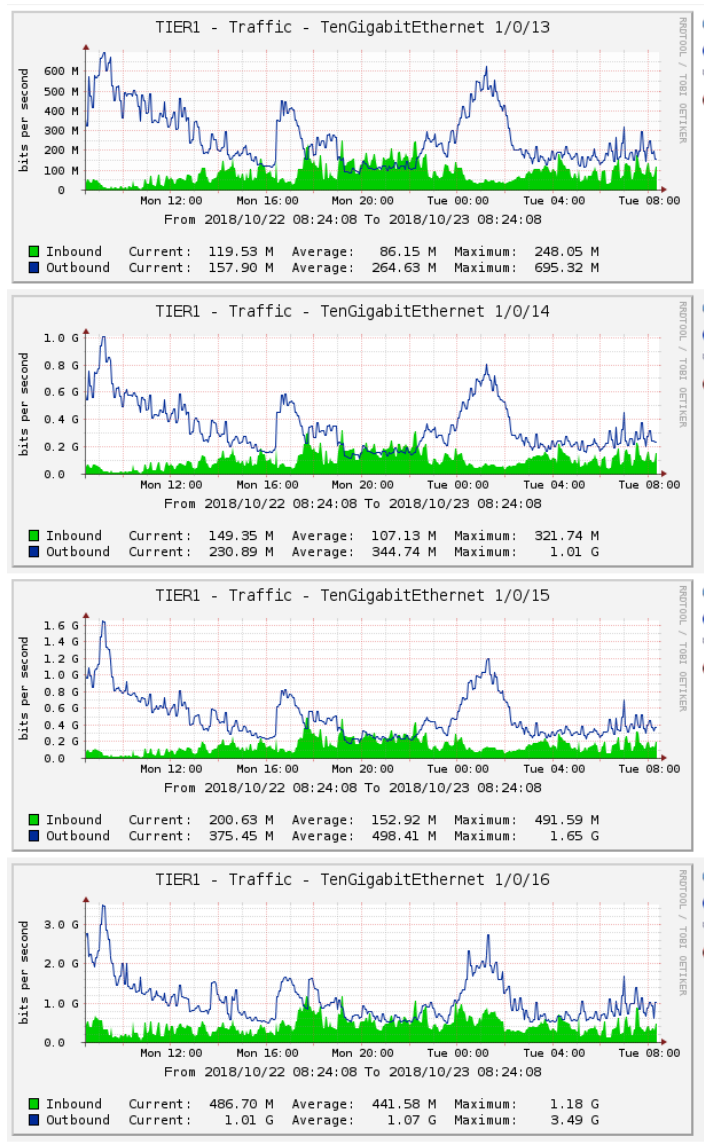
Fig. 5. S imilar example of other similar four communication Fig. 4. Example of data loading capacity in a random similar four communication lines.